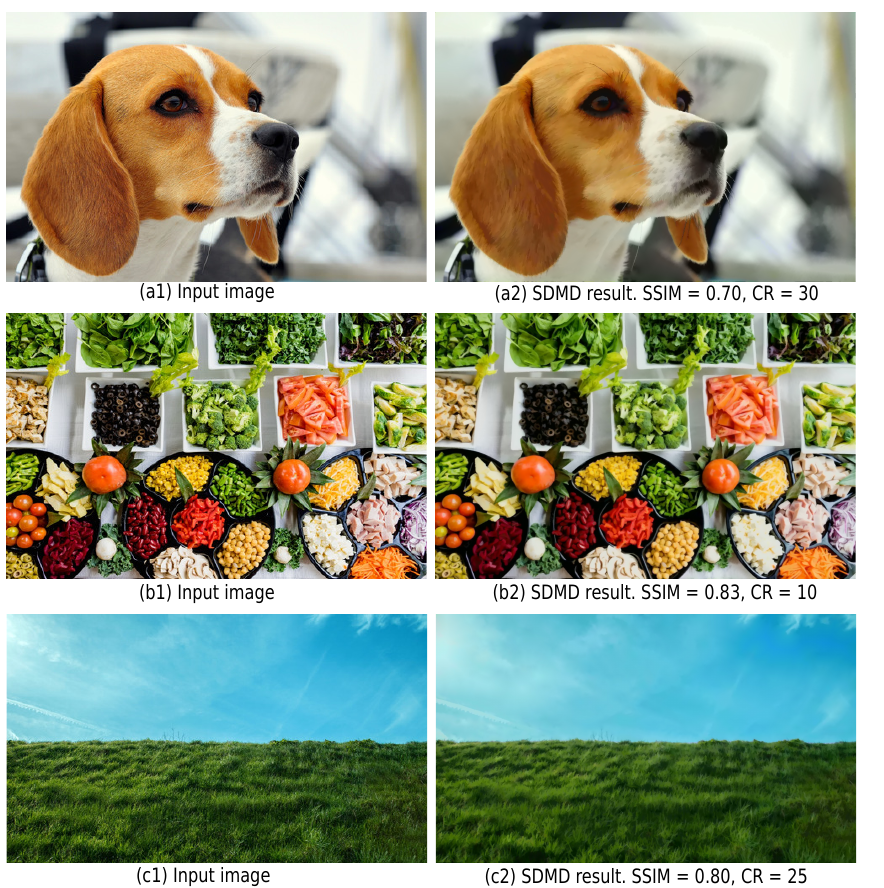
Figure 20. Poor performance (both in SSIM and CR) for SDMD when dealing with images with many fine details, such as animal furs ( a ), trivial objects ( b ), and greenery ( c ). The sizes of the three input images are all 2560 ×